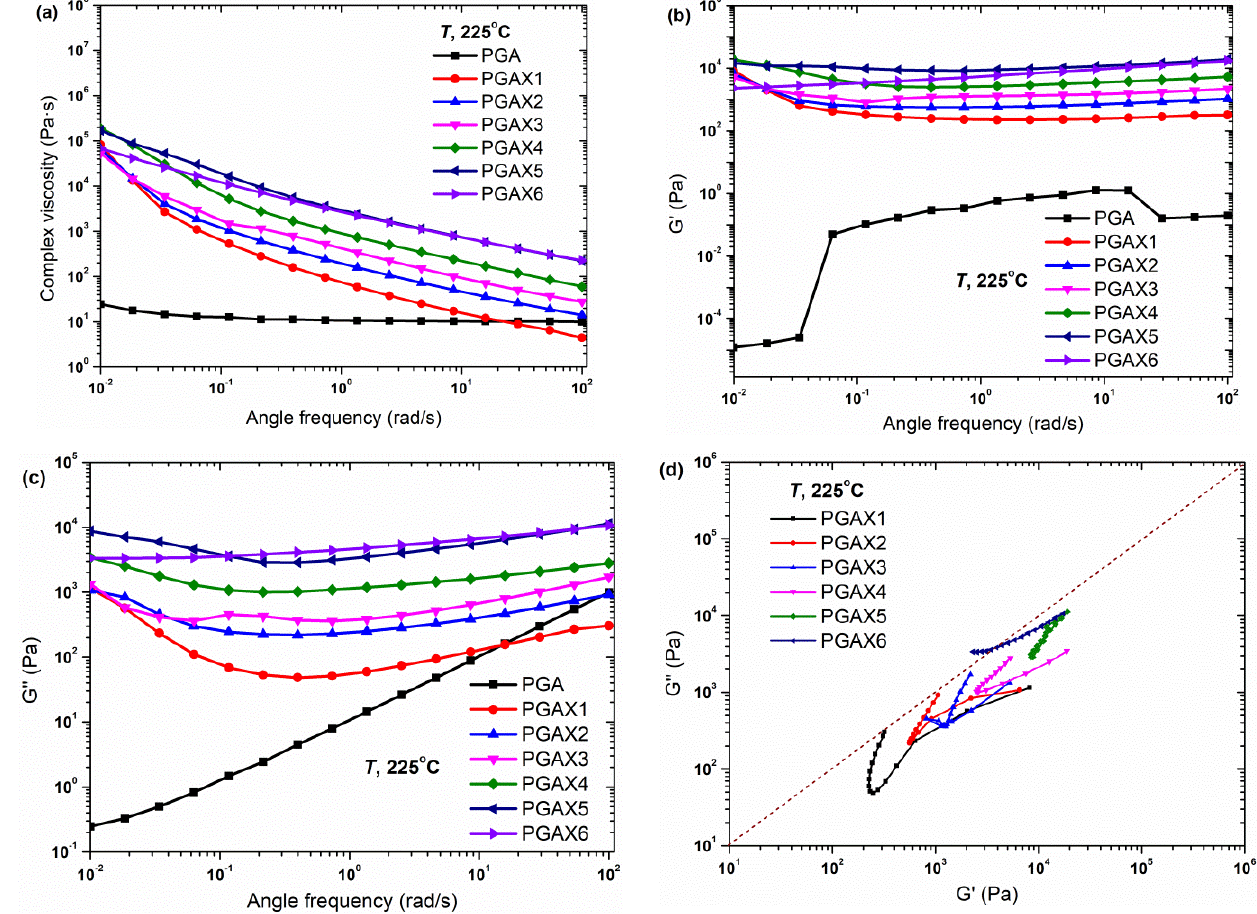
Figure 5. Rheological properties of compounded PGAX composites: ( a ) complex viscosity, ( b ) storage modulus, ( c ) loss modulus and ( d ) Cole–Cole plots.